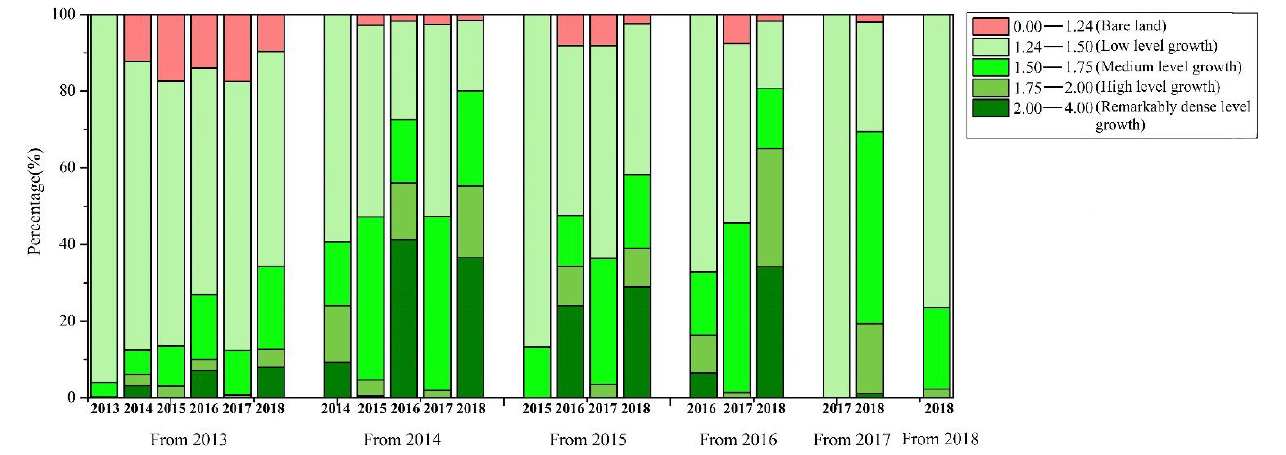
Figure 11. Inter-annual variation of restoration vegetation growth of each year from 2013 to 2018 in the study region.